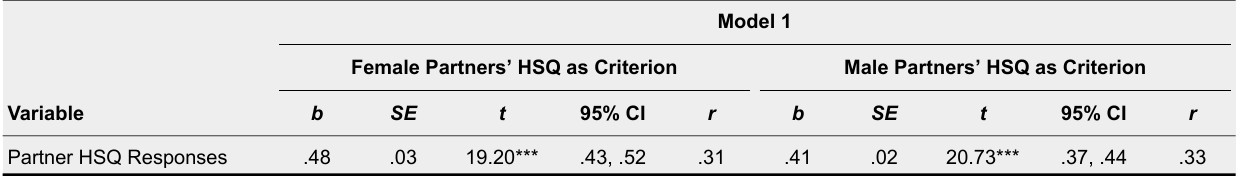
Multilevel Models Testing the Effects of One Partners’ HSQ Responses Predicting the Other Partners’ HSQ Responses (Model 1)